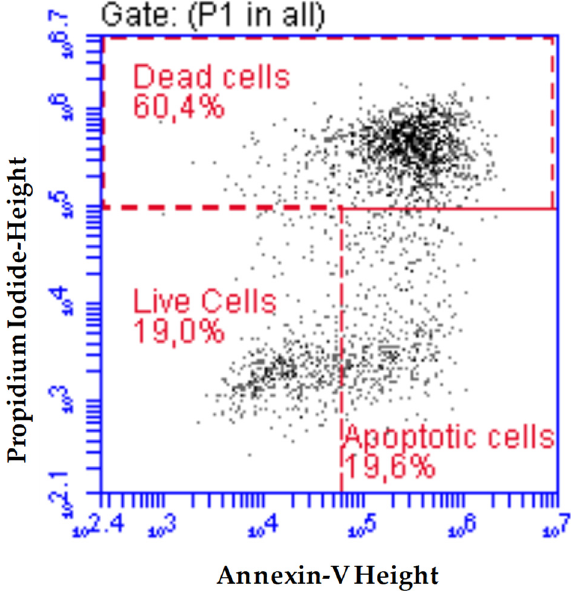
Figure 4. Compound 2g apoptosis induction.